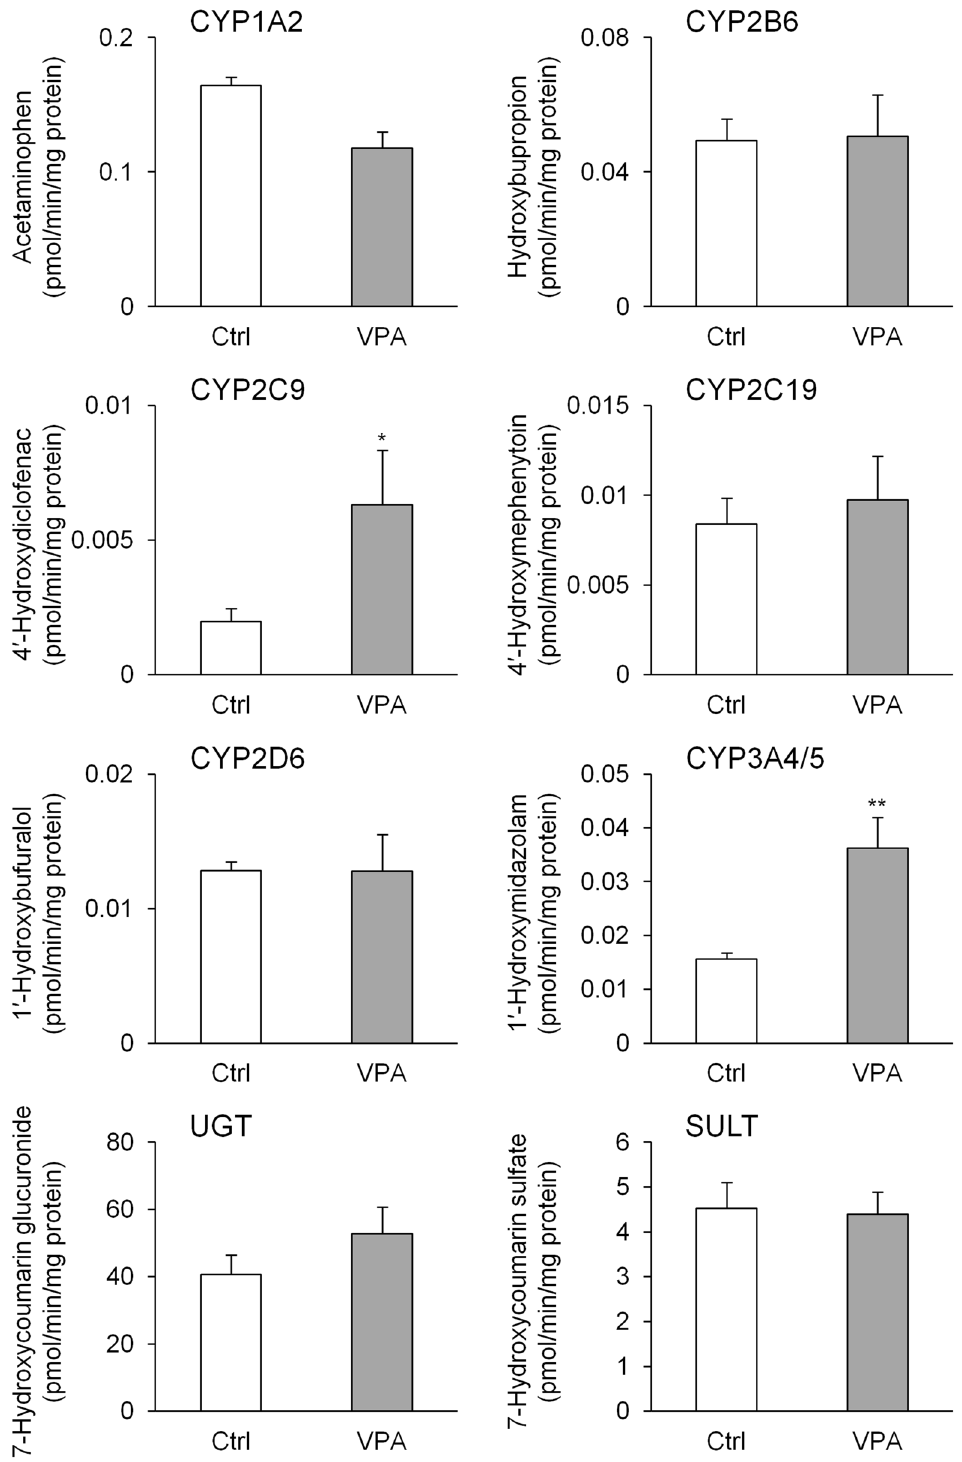
Figure 5. Drug-metabolizing enzyme activities in hepatocyte-like cells differentiated from hiPS cells using VPA. Human iPS (hiPS) cells (Windy) were differentiated into hepatocytes. Valproic acid (VPA) was added to medium for 168 h from day 12. Acetaminophen, hydroxybupropion, 4 9 -hydroxydiclofenac, 4 9 -hydroxymephenytoin, 1 9 -hydroxybufuralol, 1 9 -hydroxymidazolam, 7-hydroxycoumarin glucuronide, and 7-hydroxycoumarin sulfate were biotransformed from phenacetin, bupropion, diclofenac, ( S )-mephenytoin, bufuralol, midazolam, 7-hydroxycoumarin, and 7- hydroxycoumarin by cytochrome P450 (CYP) 1A1/2, CYP2B6, CYP2C9, CYP2C19, CYP2D6, CYP3A4/5, UDP-glucuronosyltransferase (UGT), and sulfotransferase (SULT), respectively. Each bar represents the mean 6 standard deviation ( n =3). Levels of statistical significance compared with VPA- untreated hepatocyte-like cells [control (Ctrl)]: * P , 0.05 and ** P , 0.01.